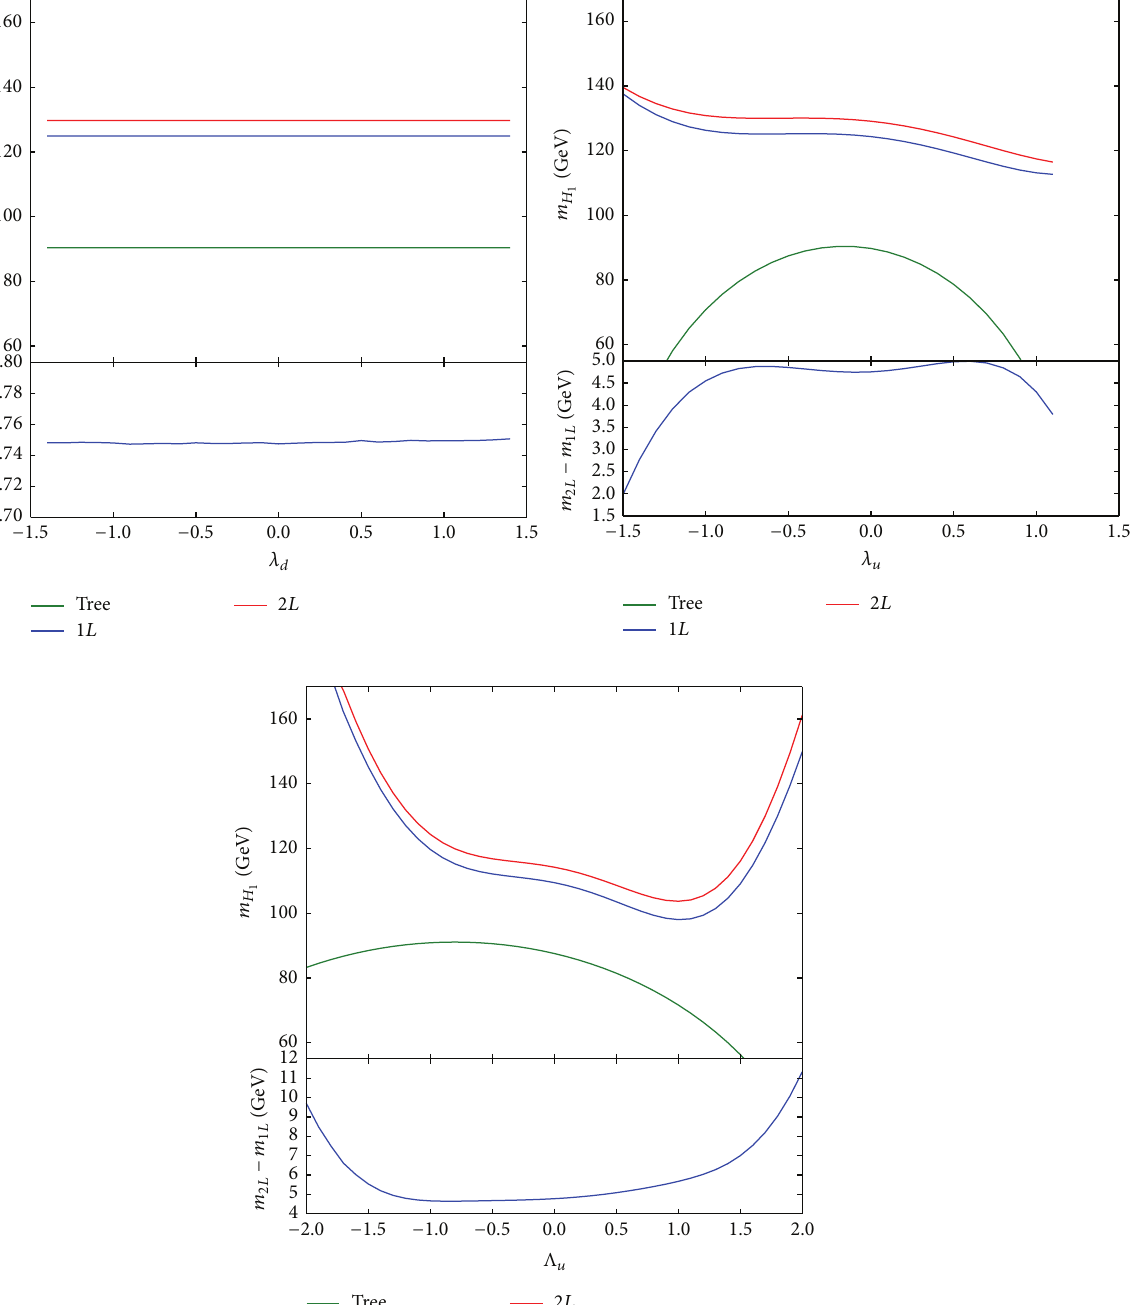
spite of the large one-loop